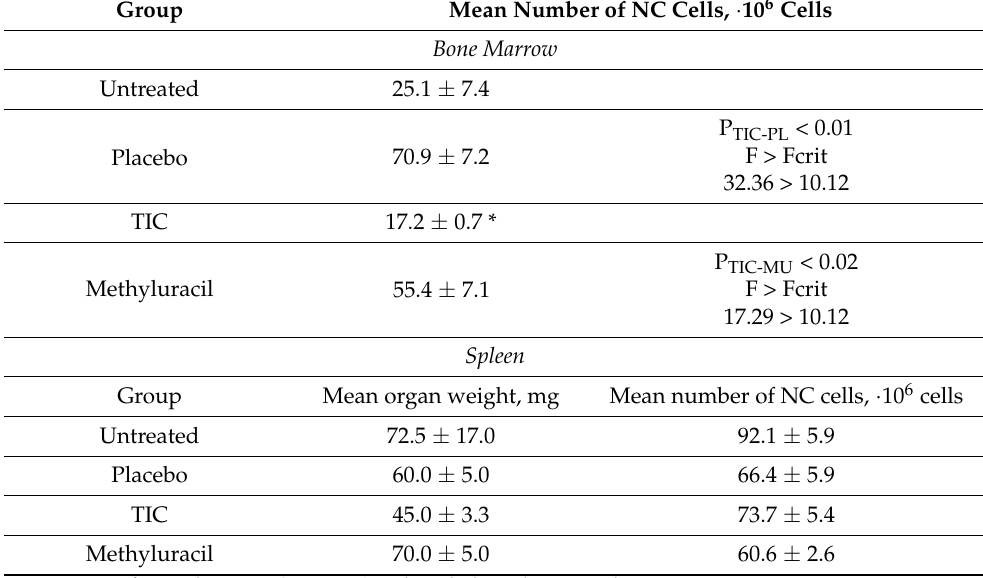
Table 1. Bone marrow and spleen cellularity .